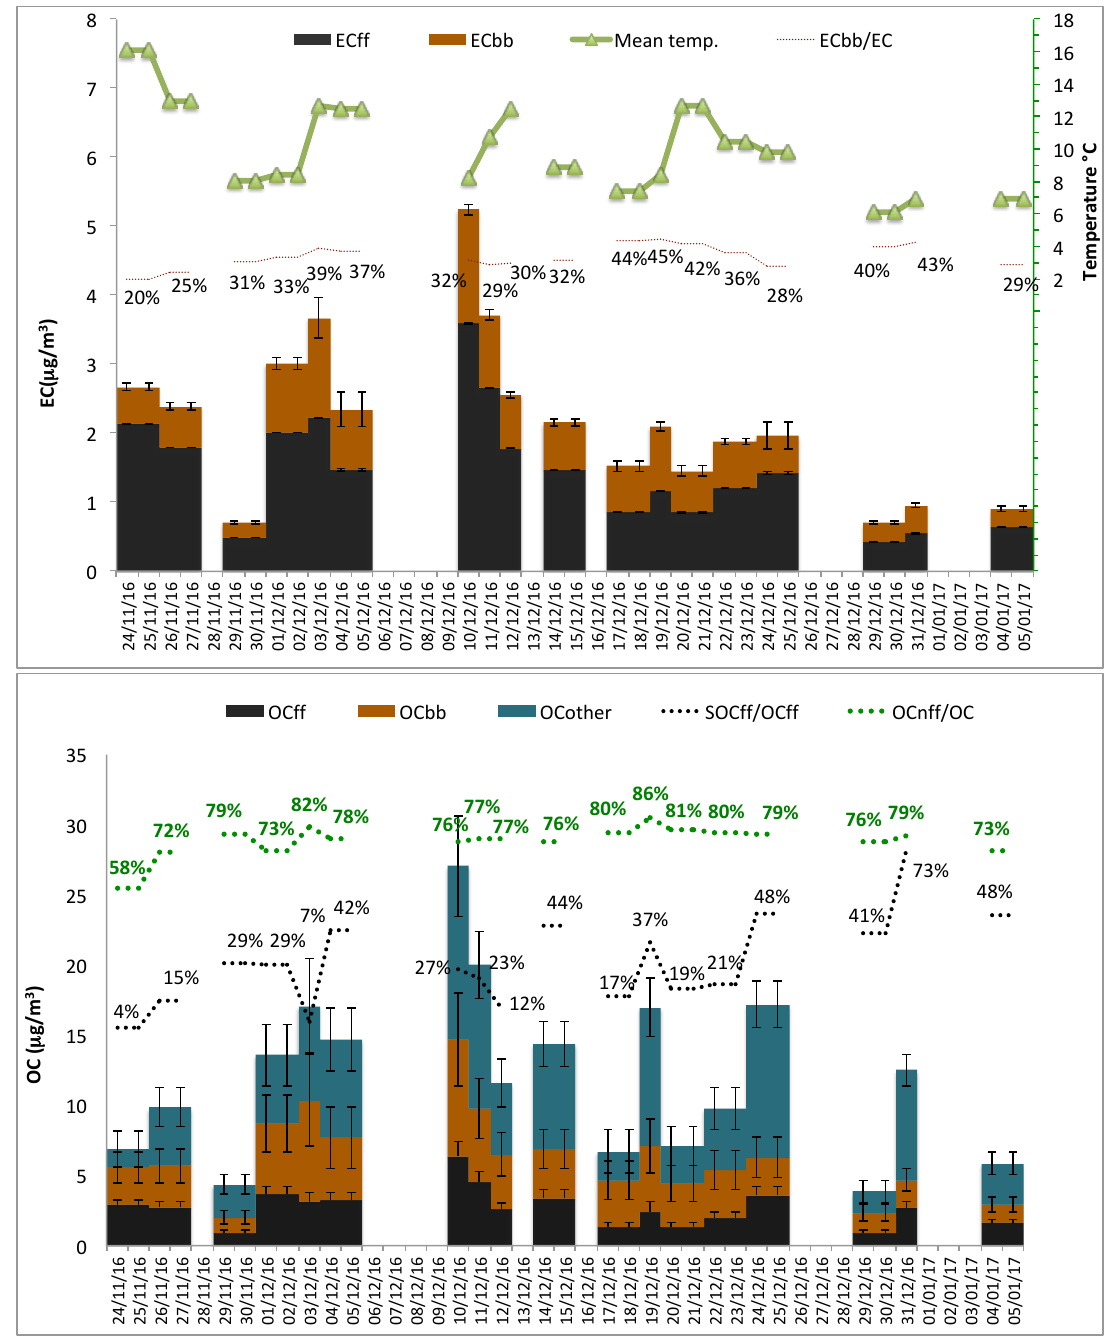
Figure 5. ( a ). Radiocarbon-based partitioning of the EC fraction. Black bars are for EC ff , and brown bars for EC bb . Error bars result by propagating uncertainties of literature parameters and observations. The fraction of EC due to biomass burning is reported in brown numbers for each sample (a dotted brown line is plotted on an arbitrary scale and guides the eyes). Mean temperature during the period covered by each sample is reported as green triangles and referred to the secondary scale of the plot. ( b ). As for Figure 5a, black and brown bars are for fossil fuel and biomass burning components, respectively. Teal blue bars show OC other , i.e., the OC fraction that is non-fossil and not attributable to biomass burning. Green figures (dotted green line to guide the eyes) give the sum of the fractions of the OC emitted directly and formed by secondary processes by all modern sources, i.e., OC bb / OC + OC other / OC. The share of OC ff derived from secondary emissions (SOC ff/ OC ff ) is given in black numbers for each sample (dotted black line to guide the eyes).